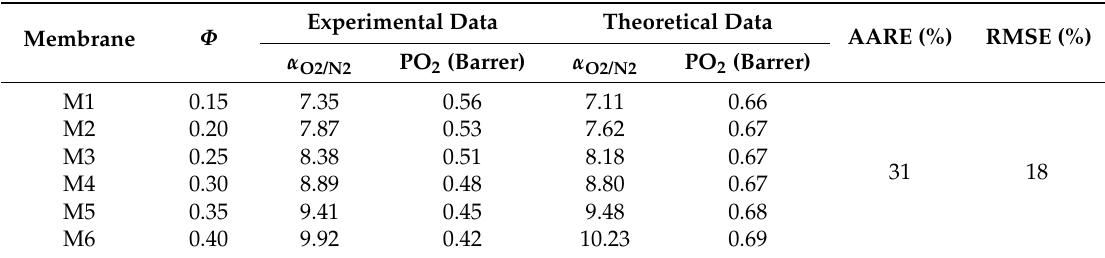
Table 4. Experimental and theoretical MOT-predicted data for the zeolite 4A-HBPI mixed-matrix membranes.